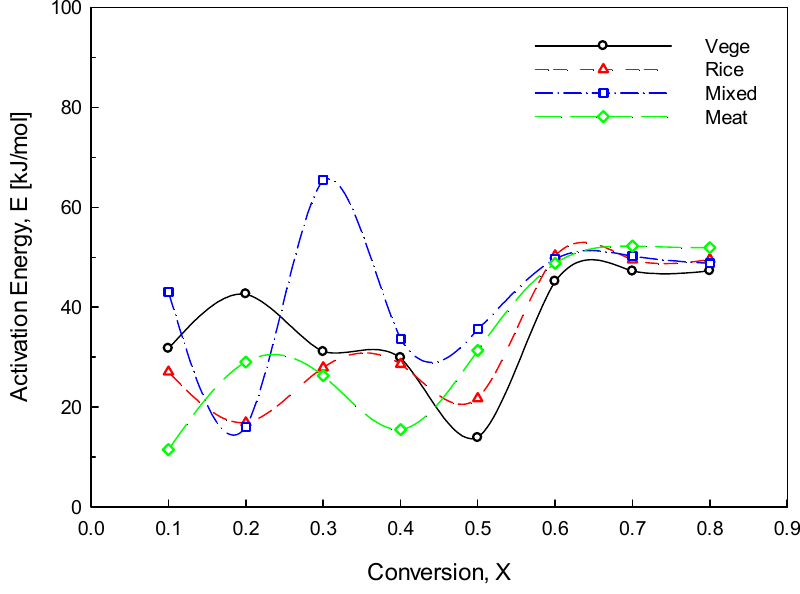
Figure 8. Calculated activation energies at different conversions for the pyrolysis of foods.